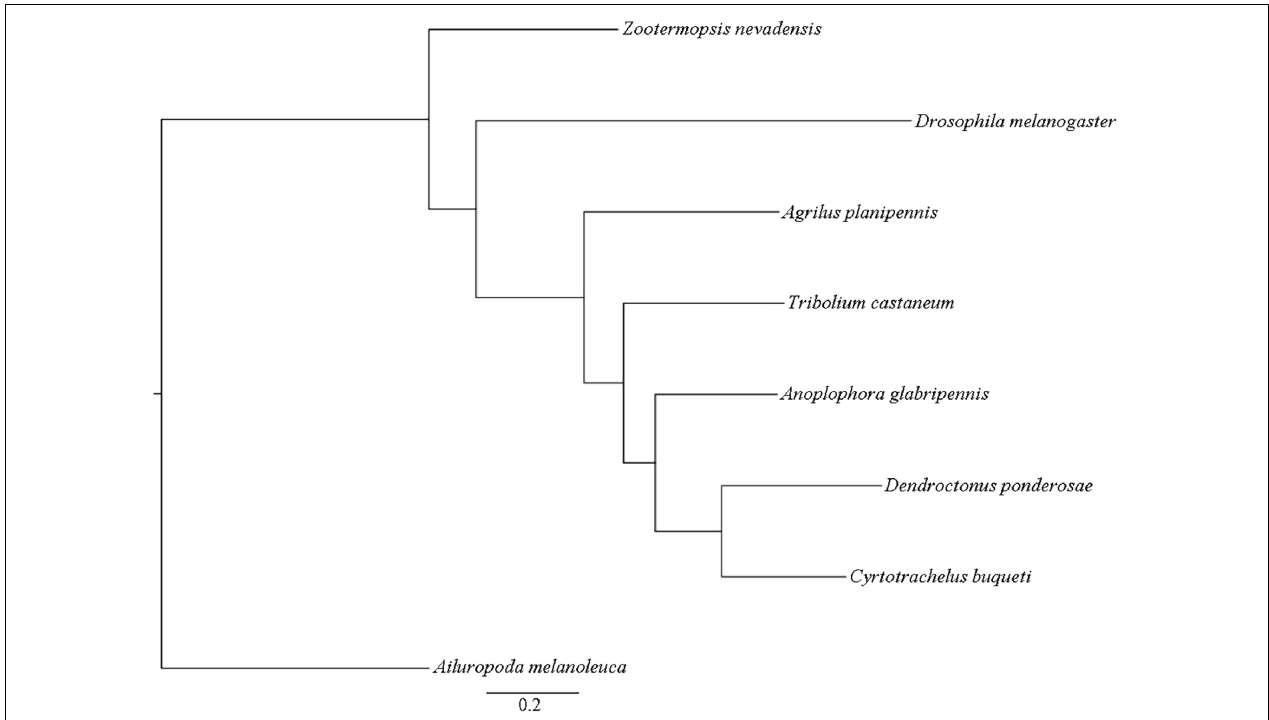
FIGURE 3 | Phylogenetic relationships of C. buqueti and seven other species.